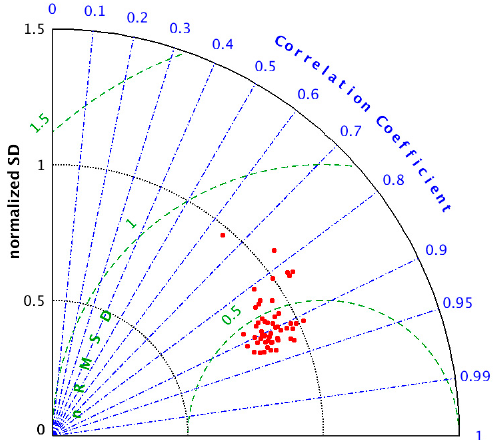
Figure 11. The Taylor Diagram of water level. Shown on the plot are the model-data correlation coefficient, normalized SD and normalized RMSE (nRMSE). coefficient, normalized SD and normalized RMSE